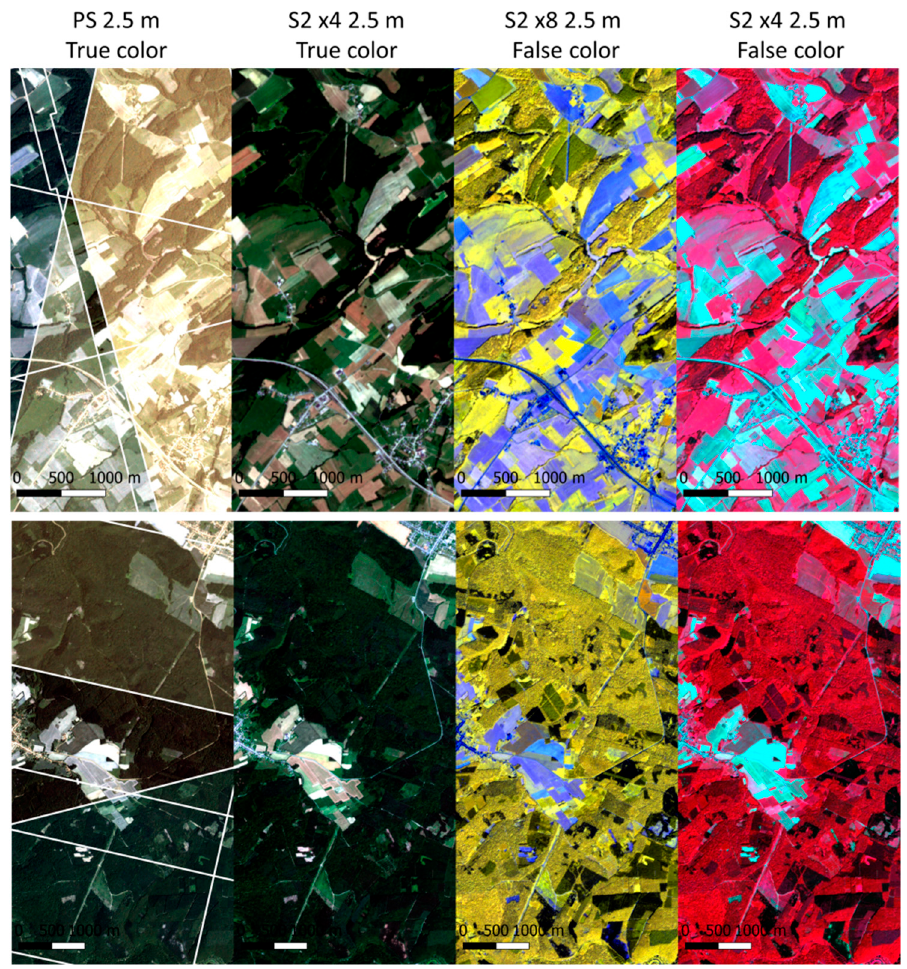
Figure 8. PlanetScope radiometry normalization of the two neural networks (NNs), from 10 to 2.5 m (×4) and from 20 to 2.5 m (×8). PS, PlanetScope; S2, Sentinel ‐ 2. There are two examples, one per row. All images are at 2.5 m. In a row, from left to right: PS in true color (R, G, and B) with scene boundaries (white lines); S2 from ×4 NN in true color (B4, B3, and B2); and S2 from ×8 NN in false color (B8a, B6, and B12) and S2 from ×4 NN in false color (B8, B4, and B3).